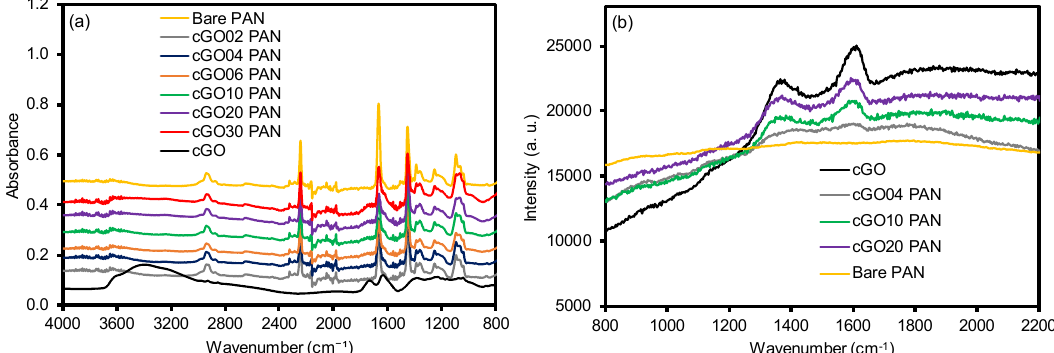
Figure 2. ( a ) FT-IR and ( b ) Raman of bare PAN, CTAC-modified GO (cGO), and composite nanofiber membranes as a function of the cGO content.